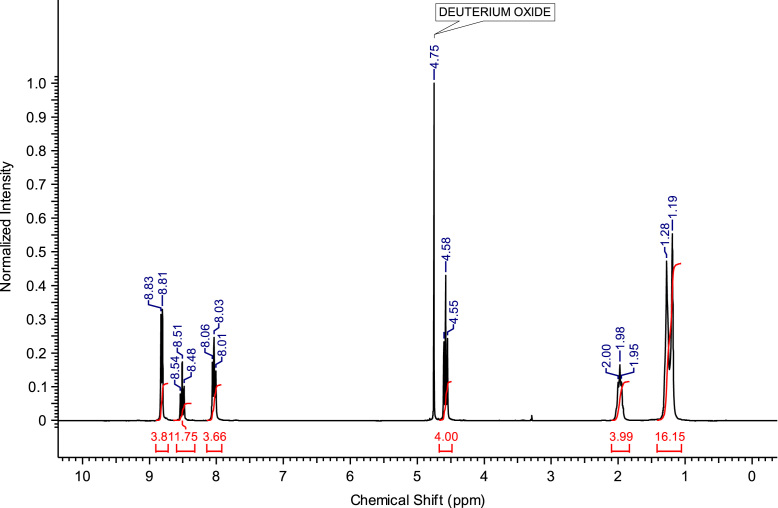
1H NMR spectra of C12(Pyr)2Br2.